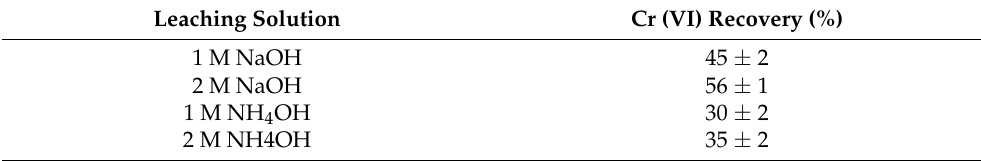
Table 5. Influence of various eluents on the desorption of Cr (VI) ions from the adsorbent. Leaching Solution